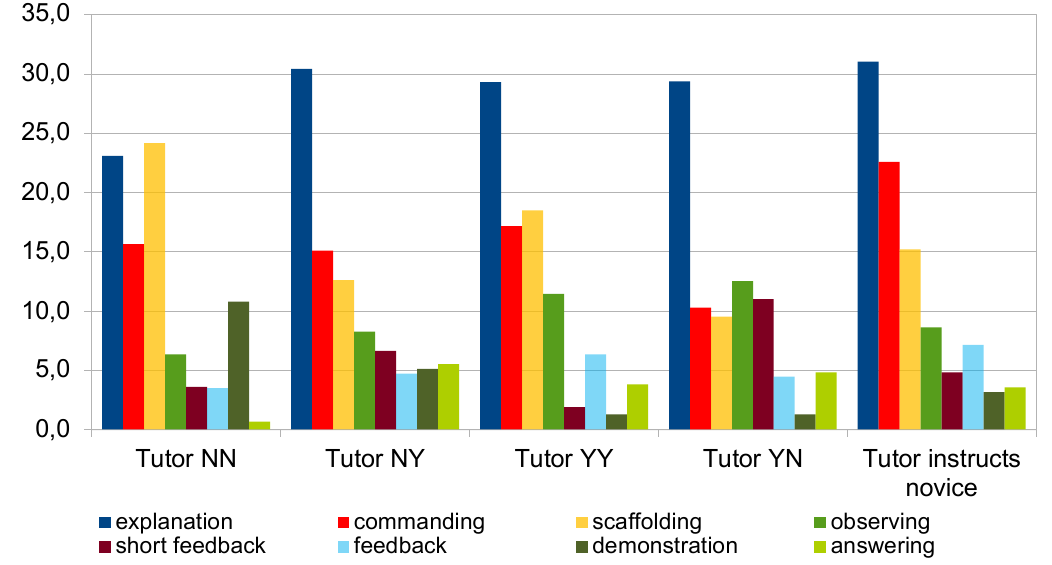
Figure 3. Most frequently used techniques by tutor subgroups